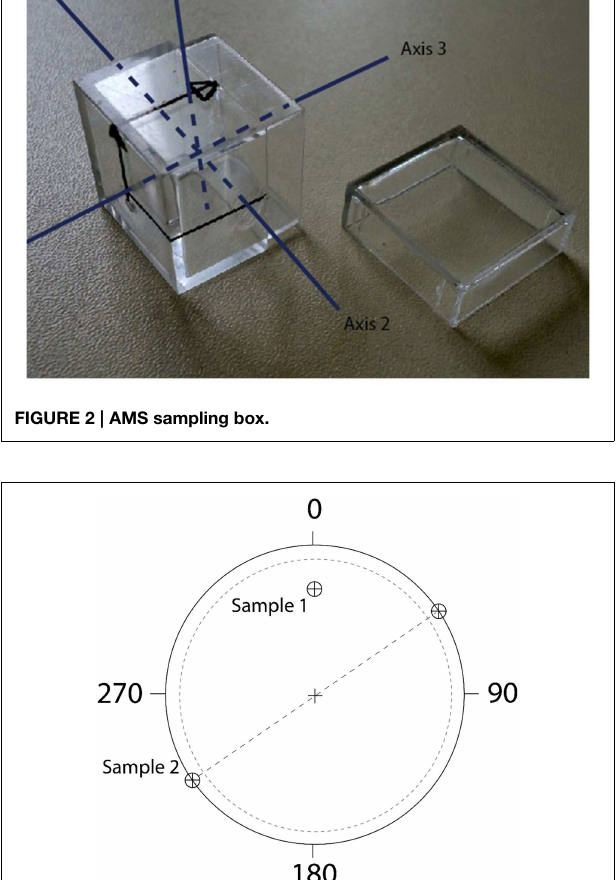
b) Sampling on moist sediments only: In order to